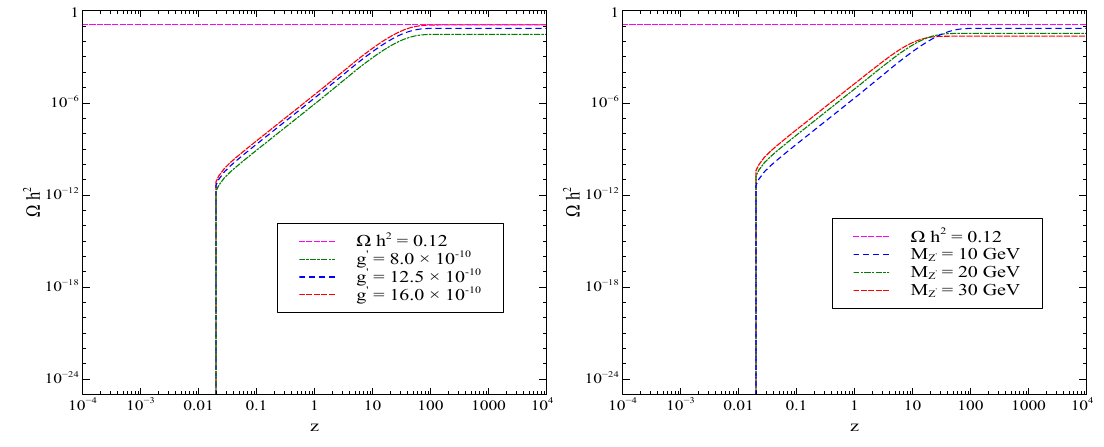
Figure 4 . Variation of the co-moving number density of Z 0 and the WDM S 1 contribution) as a function of z for di(cid:11)erent values of B (cid:0) L gauge coupling g 0 (left) where M Z 0 = 10 GeV and M Z 0 (right), where g 0 = 12 : 5 (cid:2) 10 (cid:0) 10 . Here, z 0 = 0 : 01, M and (cid:11) = 0 : 01 rad.